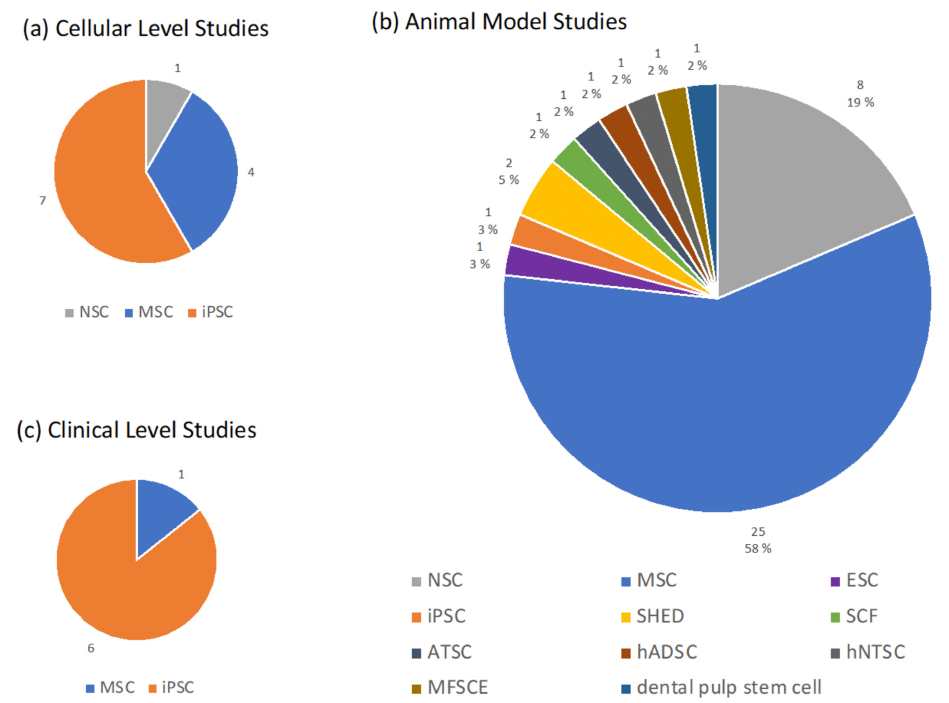
Figure 2. Distribution of stem cell types for AD therapies. ( a ) Cellular level studies, ( b ) Animal model studies, ( c ) Clinical level studies. Abbreviations: MSC (mesenchymal stem cell), NSC (neural stem cell), iPSC (induced pluripotent stem cell), ESC (embryonic stem cell), SHED (stem cell from human exfoliated deciduous teeth), SCF (stem cell factor), ATSC (adipose tissue mesenchymal stem cell), hADSC (human adipose-derived stem cell), hNTSC (human neural crest-derived nasal turbinate stem cell), MFSCE (membrane-free stem cell).